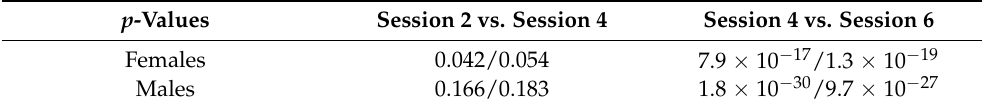
Table 5. Statistical tests (Mann–Whitney U/Wilcoxon) to assess changes in survey responses over time (sessions 2, 4, 6). p -values in bold represent significant differences for α = 0.05. p